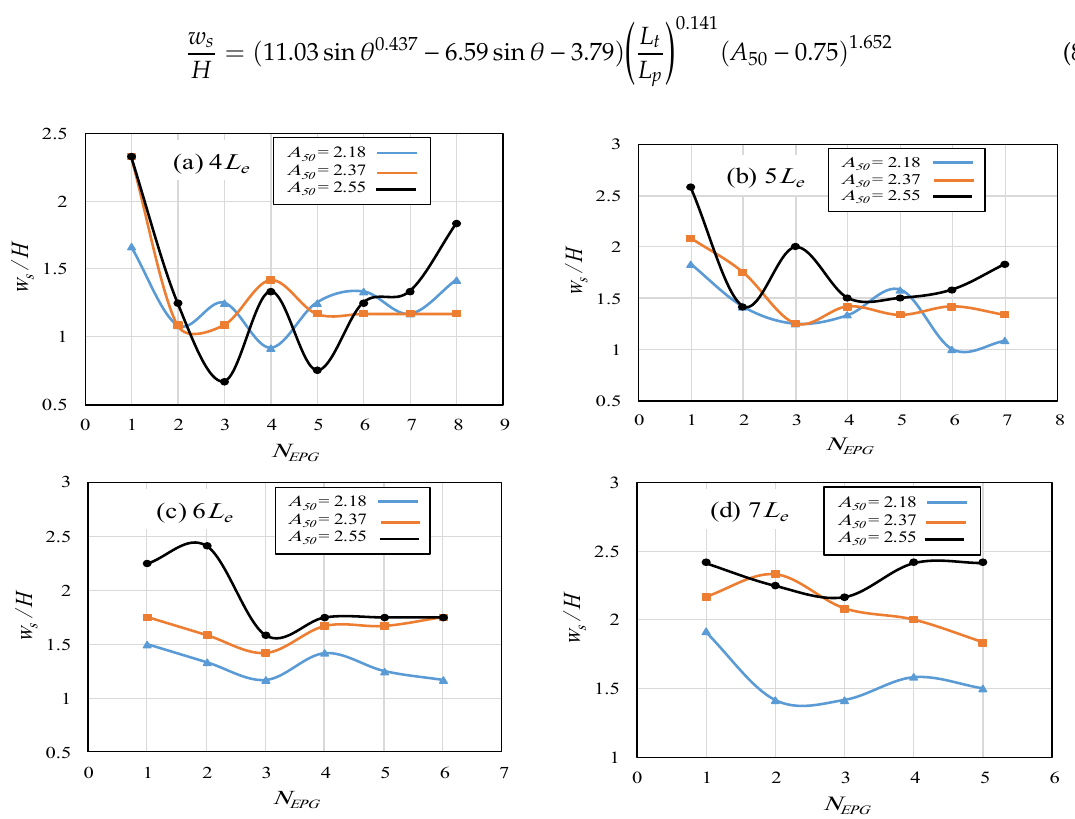
Figure 9. Relationship between the maximum scour width occurred around the first EPG and the maximum scour depth in the other EPGs at different distances. ( a ) 4 L e , ( b ) 5 L e , ( c ) 6 L e , and ( d ) 7 L e .